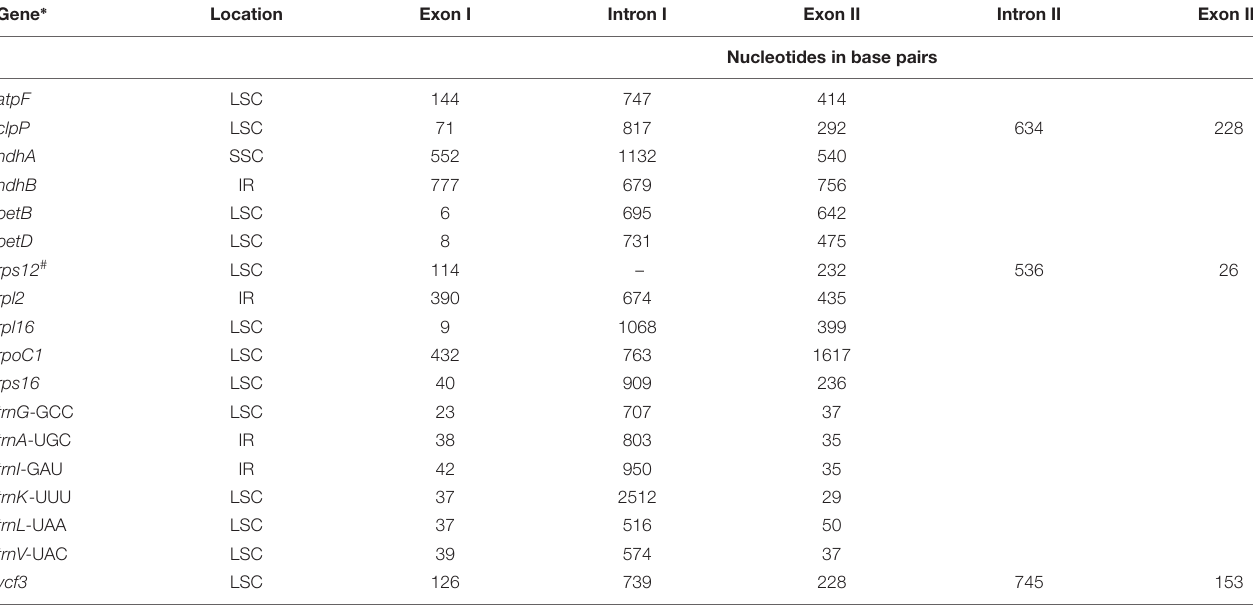
TABLE 3 | Location and length of intron-containing genes in the Ampelopsis chloroplast genome.